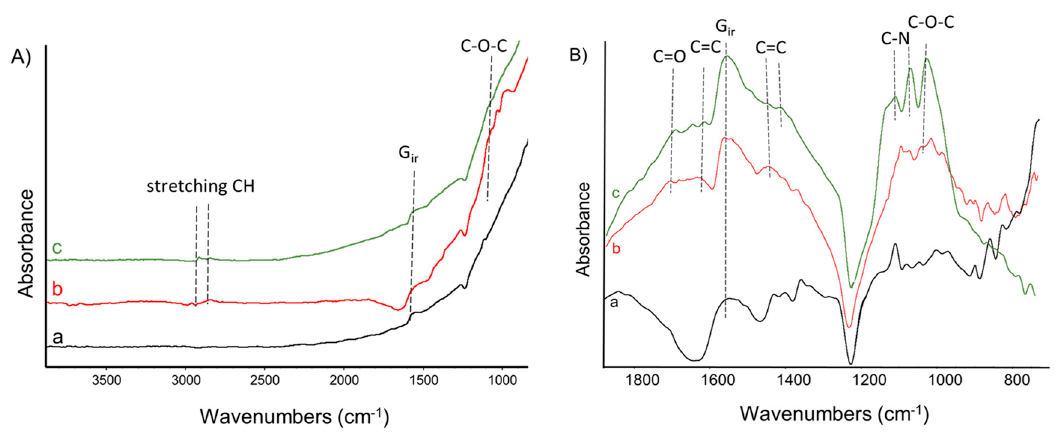
Figure 4. FT-IR spectra of MWCNT ( a ), MWCNT/PPGP s ( b ), and MWCNT/PPGP c ( c ). ( A ): 700–3900 cm − 1 region; ( B ) fingerprint region 700–1800 cm − 1 after baseline correction. Spectra are displayed with normalized intensity. Peaks discussed in the text are labeled.